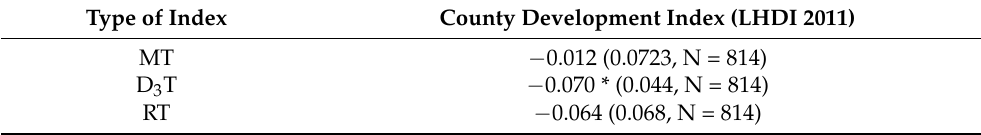
Table 6. Correlation between the MT, D 3 T, and RT indices and the development index of the county. Type of